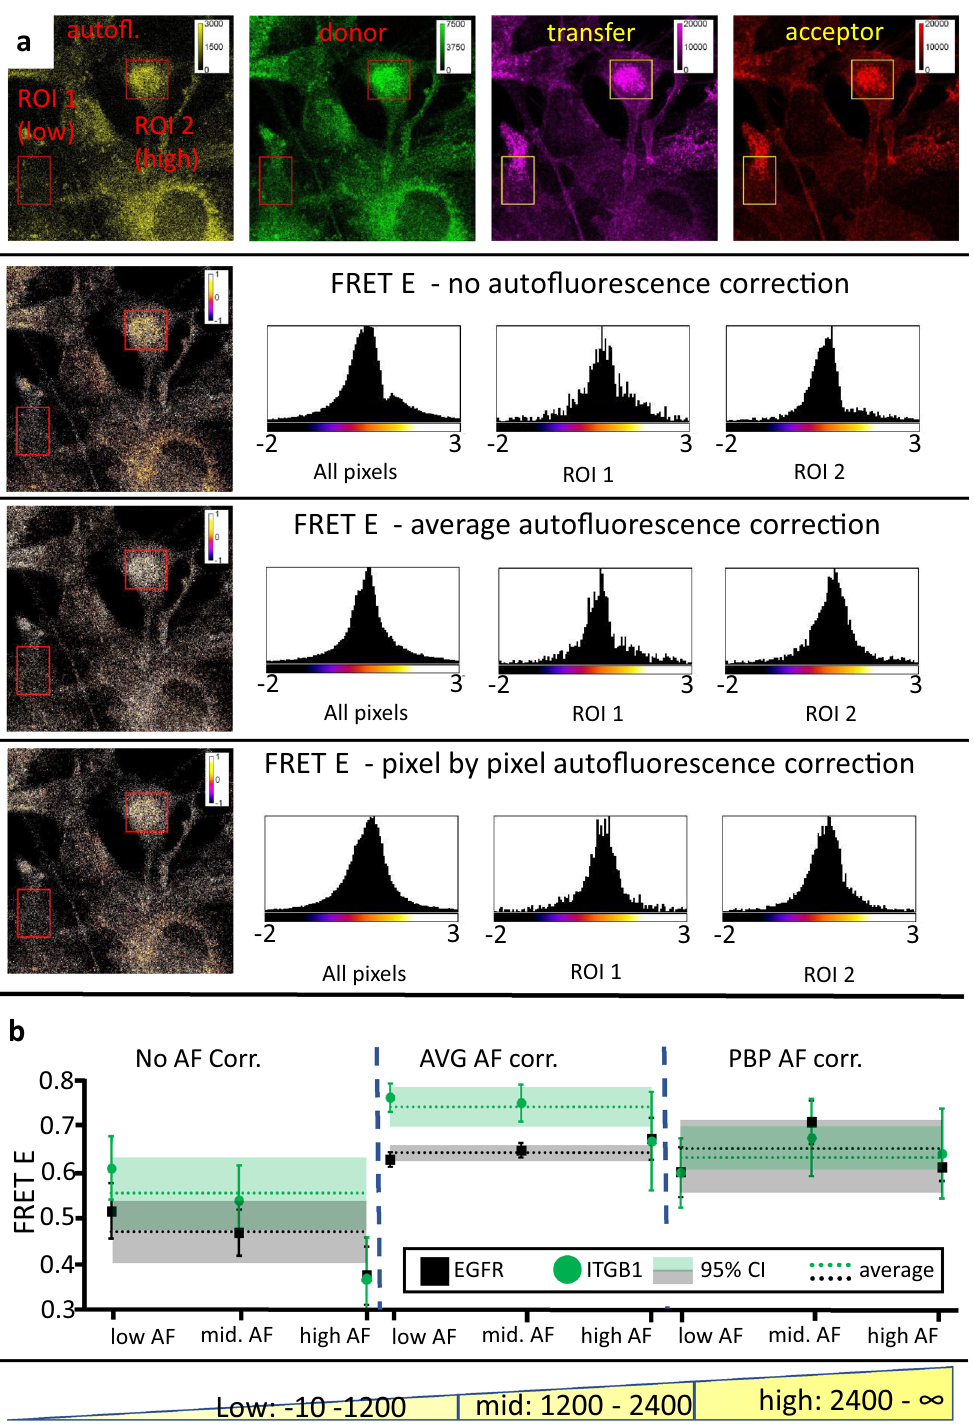
Figure 6. Effect of autofluorescence intensity on FRET calculated with different correction methods. ( a ) Sample images of the 4 fluorescent channel used for the FRET measurements (EGFR → 2nd antibody). ROI 1: low autofluorescence; ROI 2: high autofluorescence. Pixelwise distribution of FRET E for each correction method is shown for the whole image and for the low and high AF ROIs. ( b ) Pixels of 12 images each from samples prepared with EGFR and ITGB1 (low and high signal, respectively) were pooled and split into low (− 10–1.200), mid (1.200–2.400) and high (2.400–max) autofluorescence ranges. Average FRET E calculated with the three AF correction options (error bars representing ± 95% confidence interval) are plotted for each range and each sample. The global average for each sample and each correction method is also plotted (dashed lines) with its 95% confidence interval shown as bands of the same